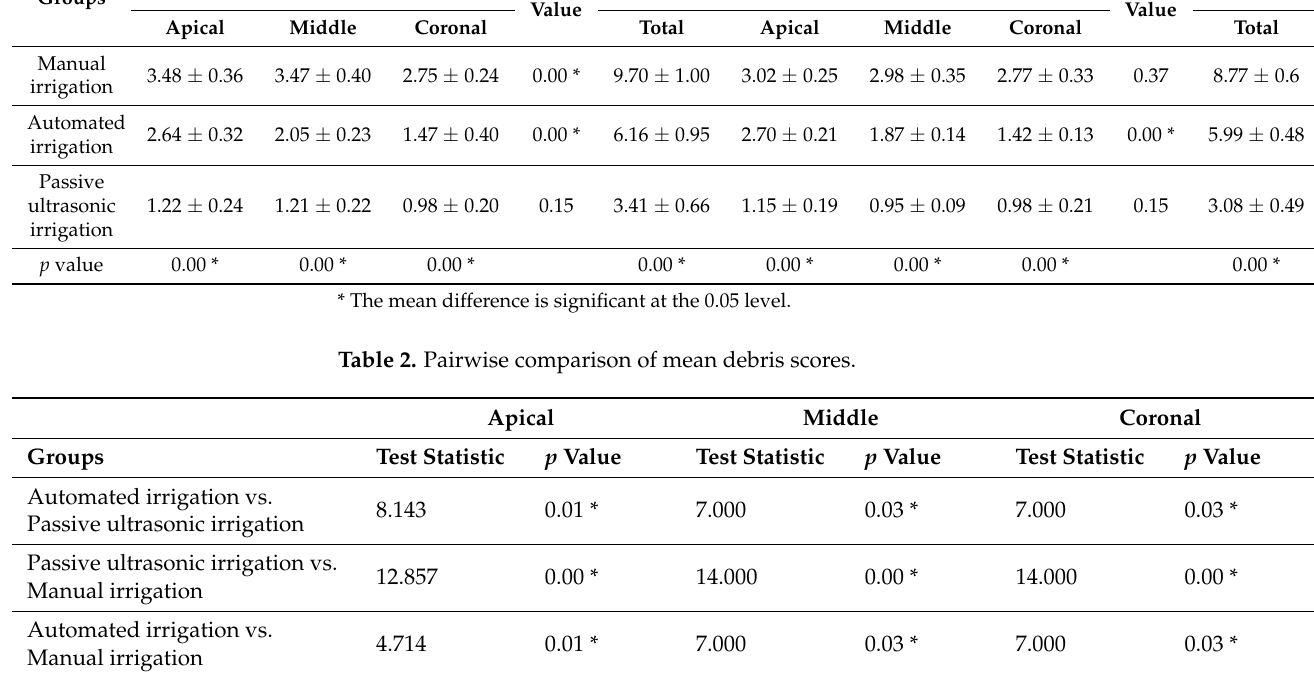
Table 2. Pairwise comparison of mean debris scores .